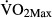
Changes in flow mediated dilatation (FMD: (A) and  :(B) in lifelong
sedentary (SED) and lifelong exercisers (LEX) on enrolment to the study (Phase A); following
conditioning exercise (Phase B) and following low frequency high intensity exercise
(LfHIIT; Phase C). Data are presented as mean ± SD.
**P <0.01 versus LEX and same
time‐point, aP <0.01 versus Phase A in
the same group, bP <0.01 versus Phase B in the
same group.